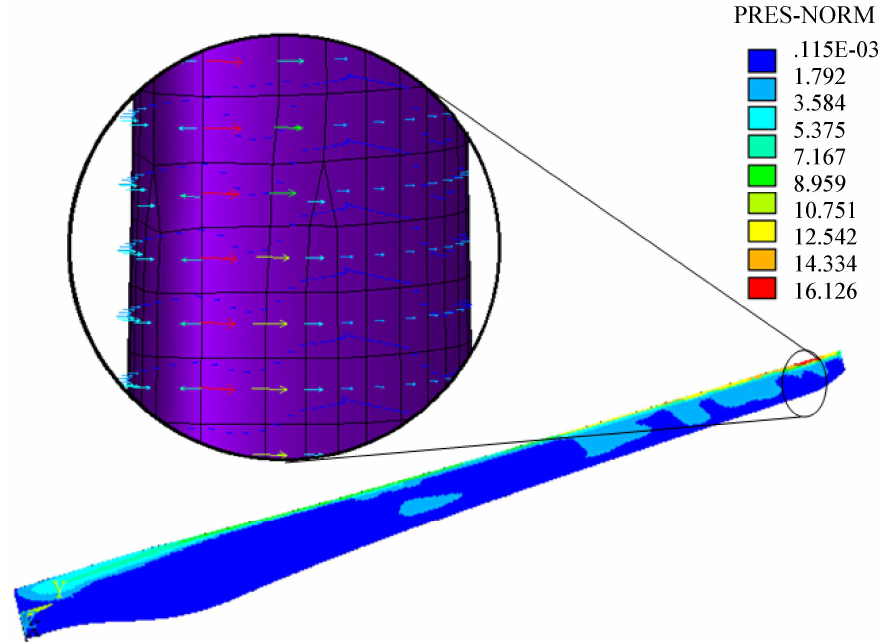
Figure 9. FE blade modal applied with limit